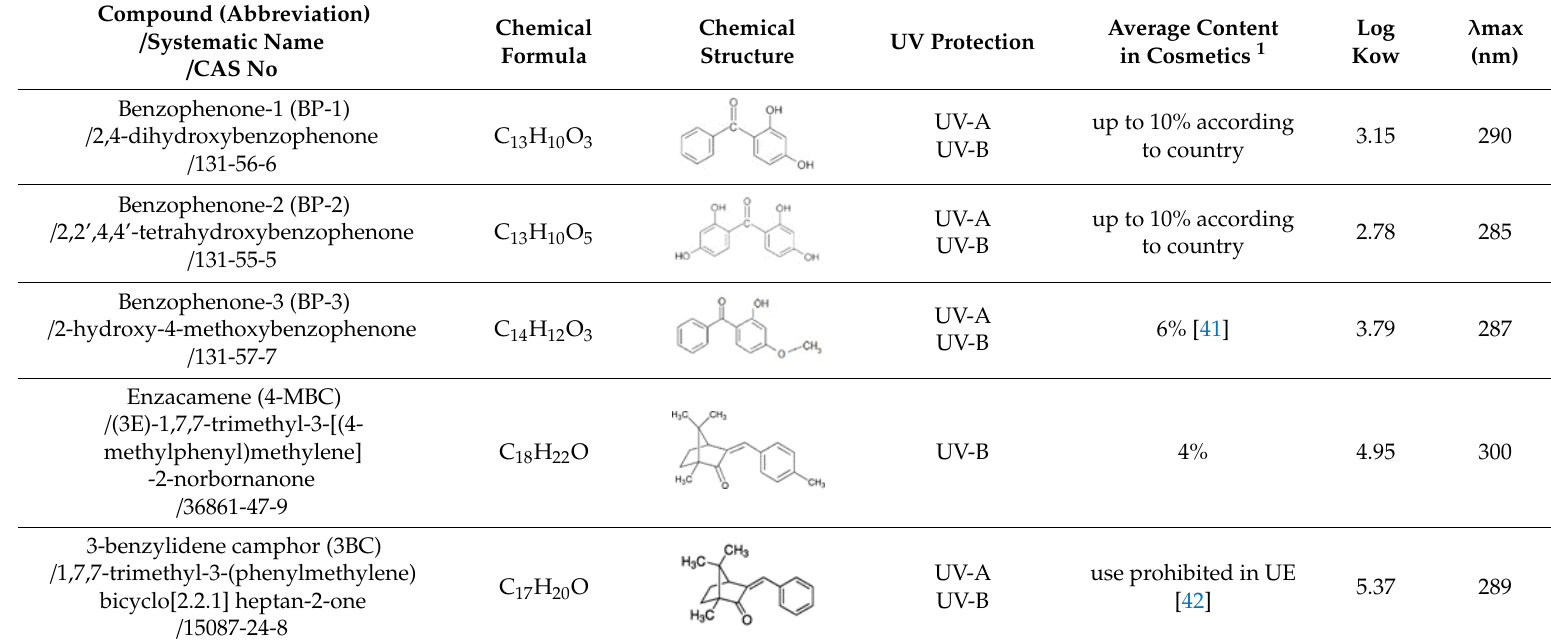
Table 1. The name, symbol, chemical formula, structural formula, type of UV radiation protection, average content in cosmetics, octanol-water partition coefficient, and analytical wavelength.